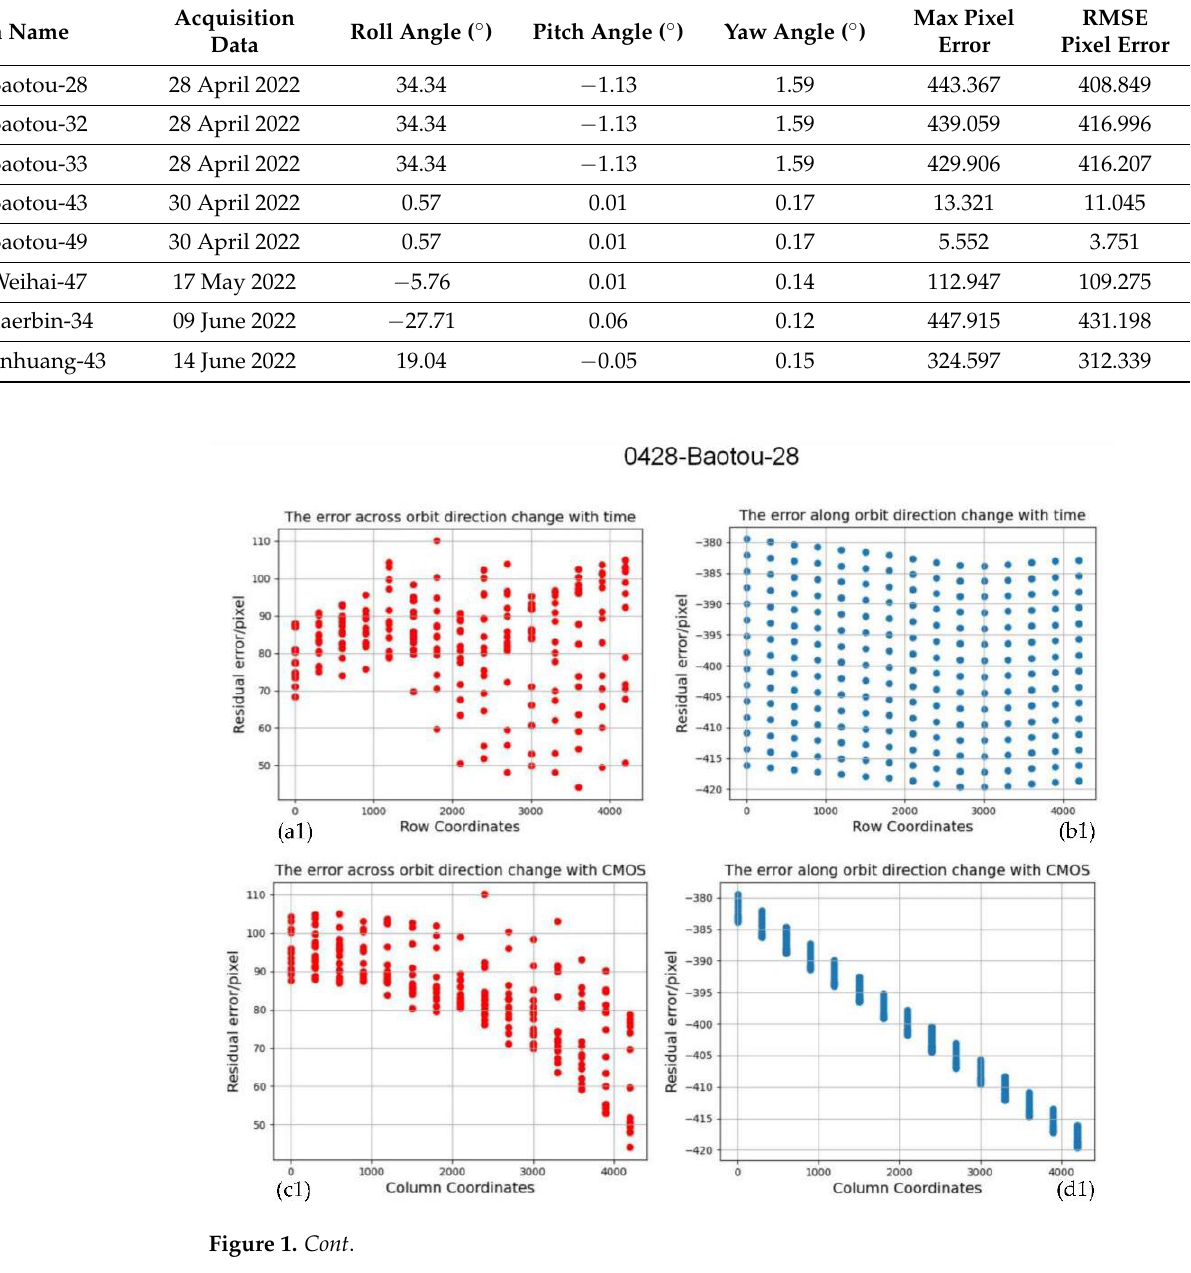
Figure 1. The error changes with time and CMOS of different images: ( a1 , a2 ) the error across orbit direction changes with time, ( b1 , b2 ) the error along orbit direction changes with time, ( c1 , c2 ) the